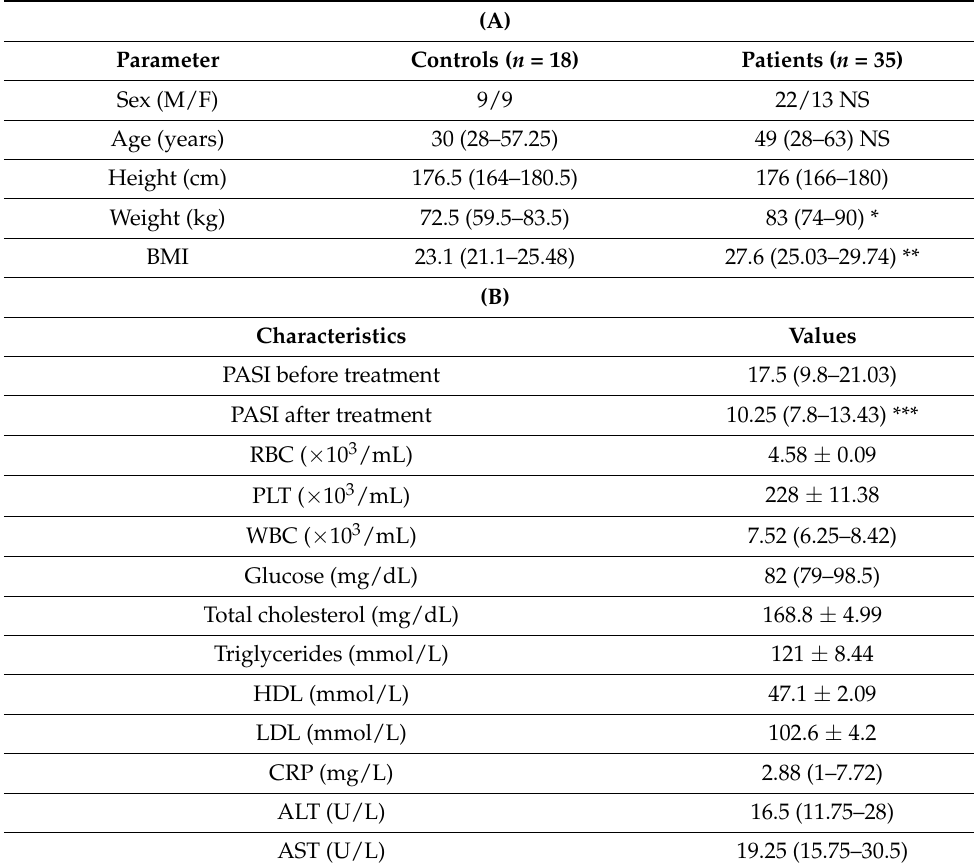
Table 1. (A) Basic characteristics of patients with psoriasis and controls without psoriasis. (B) Basic characteristics of the patient group with